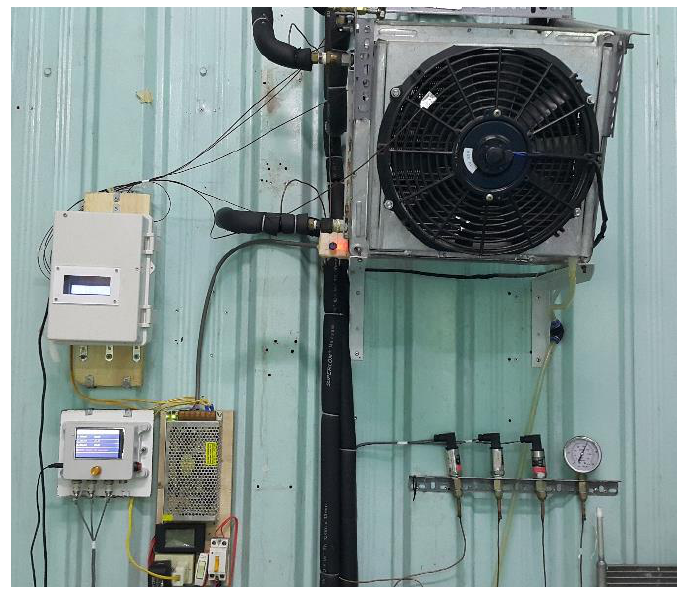
Figure 6. A V-finned tube evaporator for the CO 2 air conditioning system.